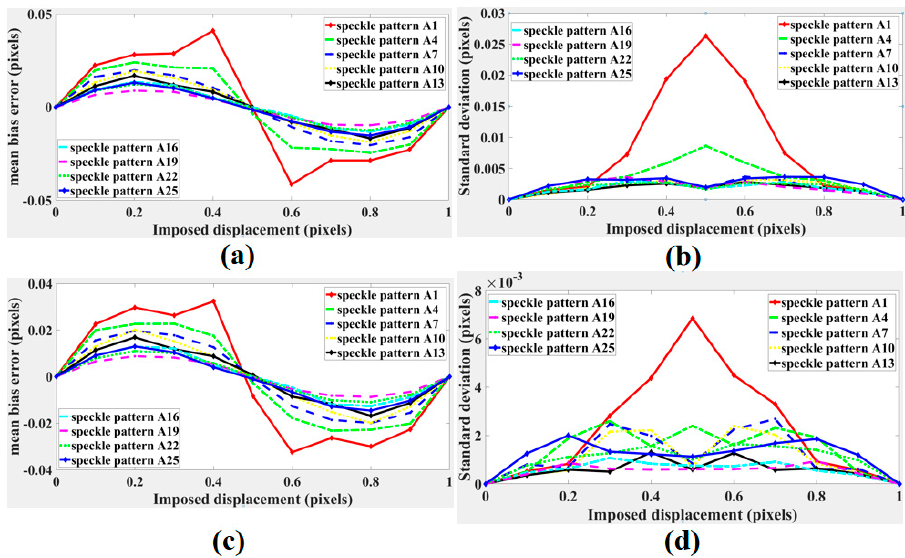
Figure 7. ( a ) Mean bias errors and ( b ) standard deviations of speckle patterns displacements in group A calculated with the subset of 31 × 31 pixels. ( c ) Mean bias errors and ( d ) standard deviations of speckle patterns displacements in group A calculated with the subset of 61 × 61 pixels.